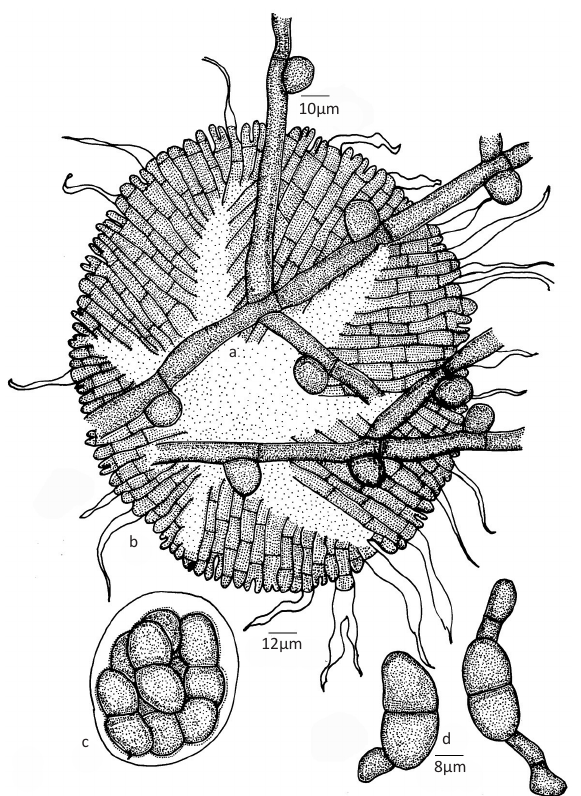
Figure 3. Viegasia cissampeli (Hansf.) Bat. a - Appressoriate mycelium; b - Thyriothecium; c - Ascus; d - Ascospores; e -